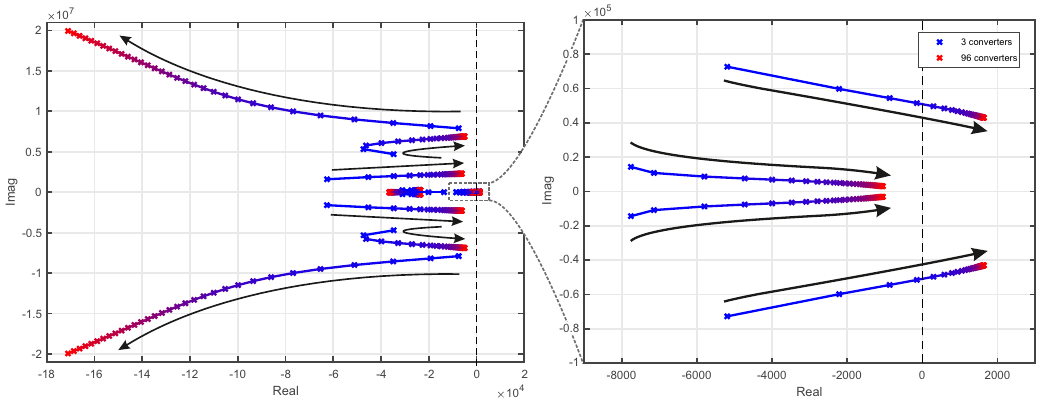
Figure 13. Pole path for critical system poles as the number of paralleled PSUs is